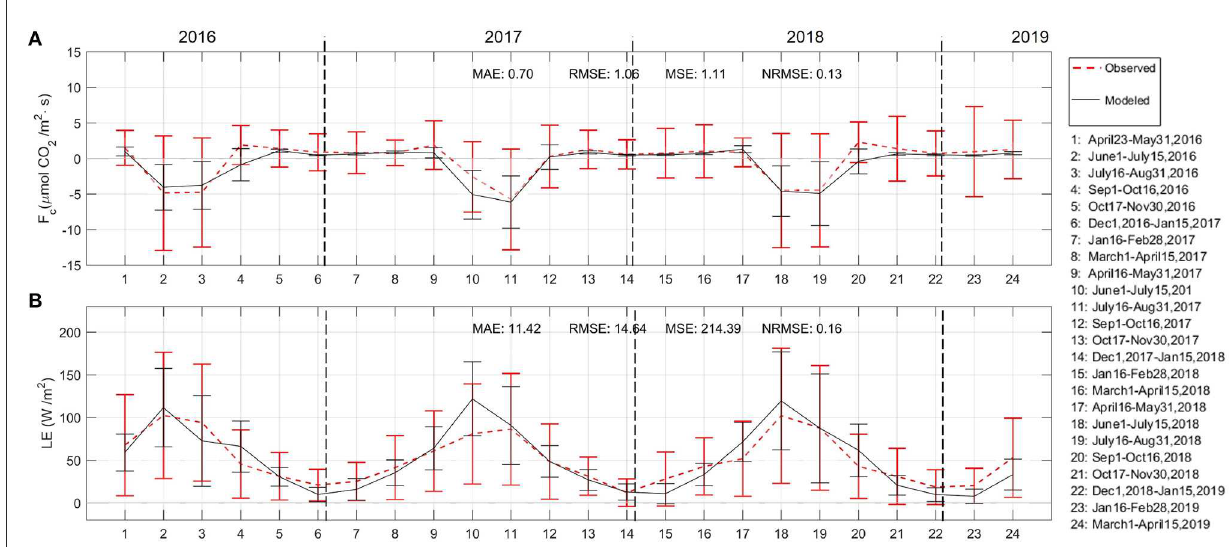
FIGURE10 Differences between flux tower observations (red) and modeled (gray) daily averaged fluxes in 6-week windows, for (A) carbon dioxide flux, F c , and (B) latent heat flux, LE . The error bars show the standard deviation of the daily average over the 6-week period for the observed (red) and modeled data (gray). The segmented line in red shows the behavior of the daily averaged observations, while the continuous black line similarly shows the modeled data. Dashed vertical lines show the years of analysis. The Mean Absolute Error (MAE), Root Mean Squared Error (RMSE), Mean Squared Error (MSE), and Normalized Root Mean Squared Error (NRMSE), support the evaluation of the goodness of fit between observed and modeled data.